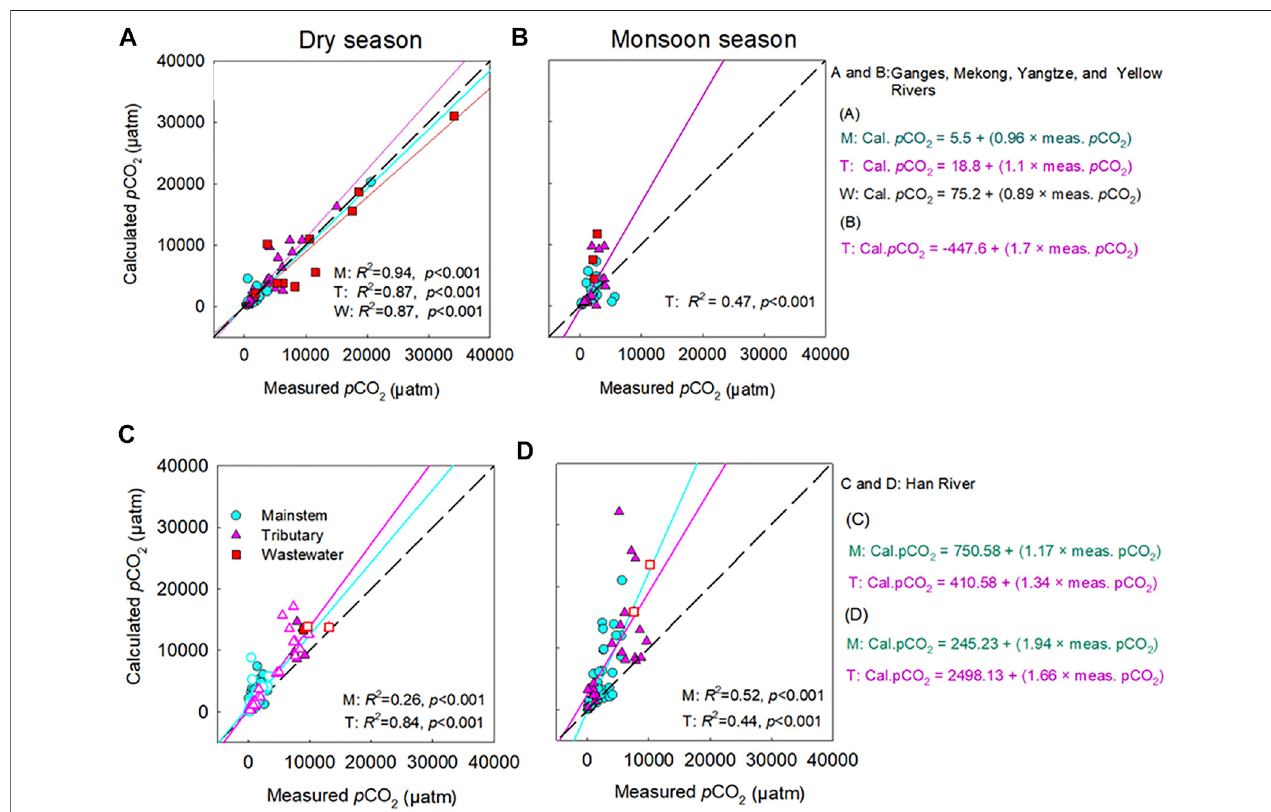
FIGURE 3 | Comparison of the measured and calculated partial pressure of CO 2 ( p CO 2 ) in the mainstems (M), tributaries (T), and polluted urban tributaries or wastewater ef fl uents (W) of the four large Asian rivers [ (A,B) : the Ganges, Mekong, Yangtze, and Yellow River] and Han River (C,D) between the dry season (A, C) and monsoonseason (B,D) .Forthefourlargerivers,122datapointsarepresentedfrom Figure2 (excluding8sampleswiththelargediscrepanciesbetweenthecalculated andmeasuredvaluesobtainedatpH < 6.5andpH < 6.3duringthemonsoonanddryperiods,respectively),includingthemainstem(M)(n:27formonsoonseason; 23fordryseason),tributaries(T)(n:27formonsoonseason;31fordryseason)andwastewater(W)(n:4formonsoonseason;10fordryseason)from2015to2019.For the HanRiver, 209data pointsarepresentedfrom Figure2 (excluding 9sampleswiththelarge discrepancies betweenthecalculatedand measured valuesobtainedat pH < 6.4 during thedryperiods), including the mainstem (M) (n:53 for monsoon season;81 for dry season), tributaries(T)(n: 25 formonsoon season; 44 fordry season) and wastewater (W) (n: 2 for monsoon season; 4 for dry season) from 2014 to 2020. For the Han River, dry seasonal samples are indicated by fi lled symbols for the months without “ rainfall, ” while void symbols represent the months with “ sporadic rainfall. ” The signi fi cant relationship ( p < 0.05) is indicated by the regression line, while the dashed black line represents the 1:1 line.